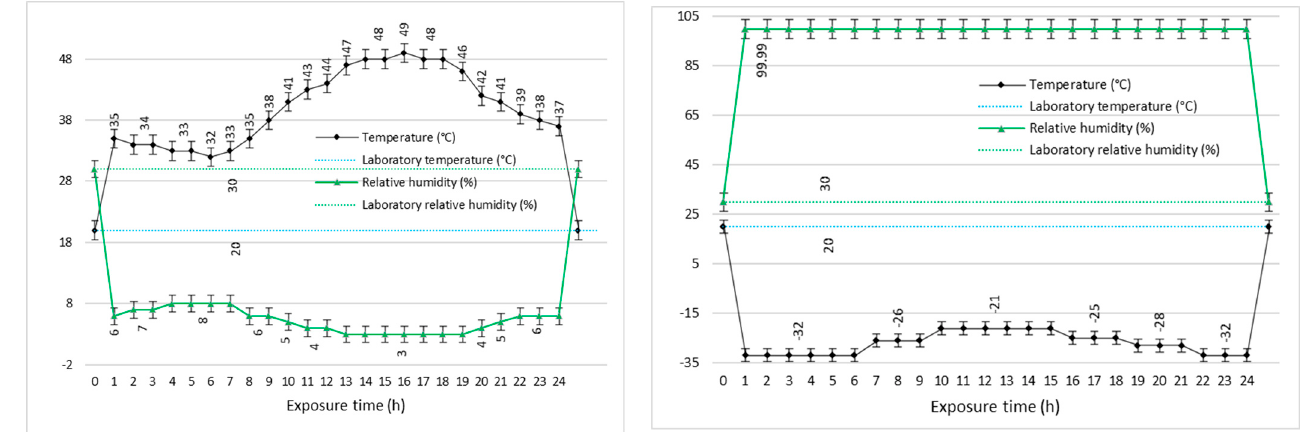
Figure 7. Temperature cycles assay on neat DS. Table 5. Decontamination efficiency of neat DS on sulfur mustard (HD) and soman (GD).